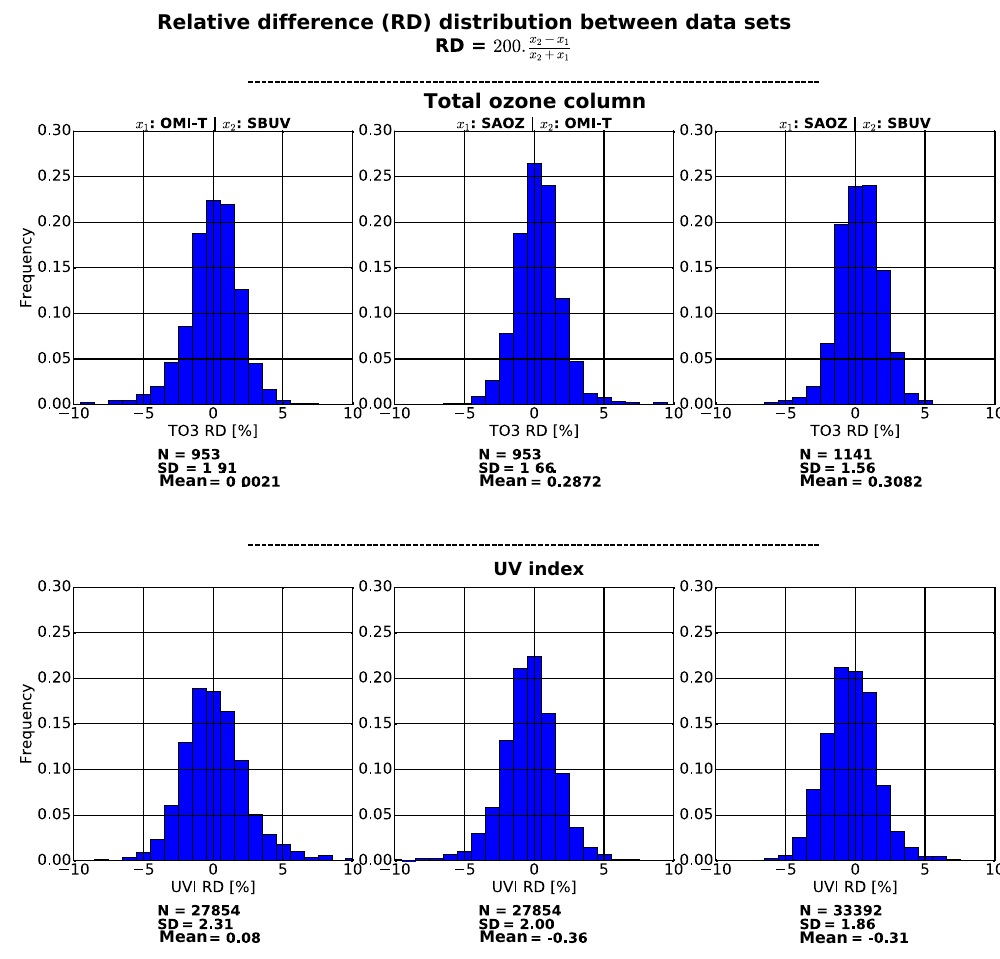
Figure 6. Distribution of relative difference (%) between different TO 3 data sets and between the corresponding surface UVI modelled at all